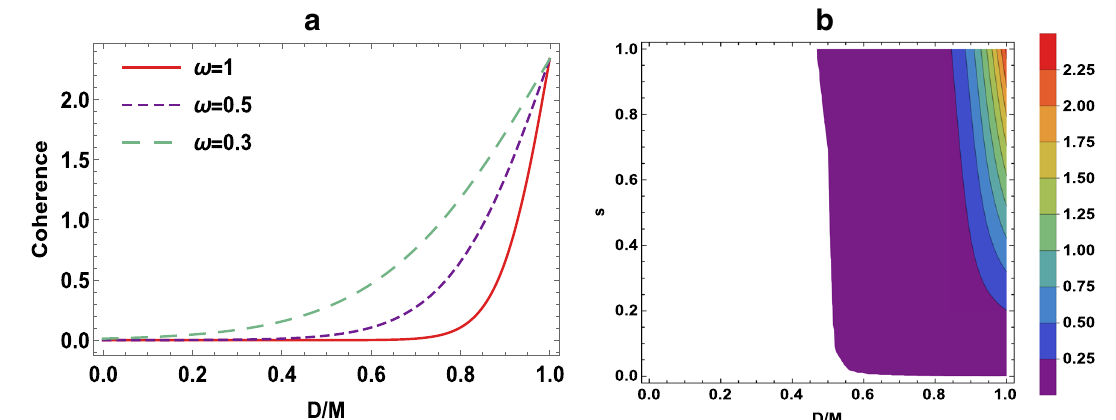
Fig. 3 a Plots of the quantum coherence between Alice and anti-Bob as a function of the ratio D / M . The initial squeezing parameter is fixed as s = 1 and the frequency of the field are ω = 1 (red line), ω = 0 . 5 (purple dotted line), ω = 0 . 3 (green dotted line), respectively. b The